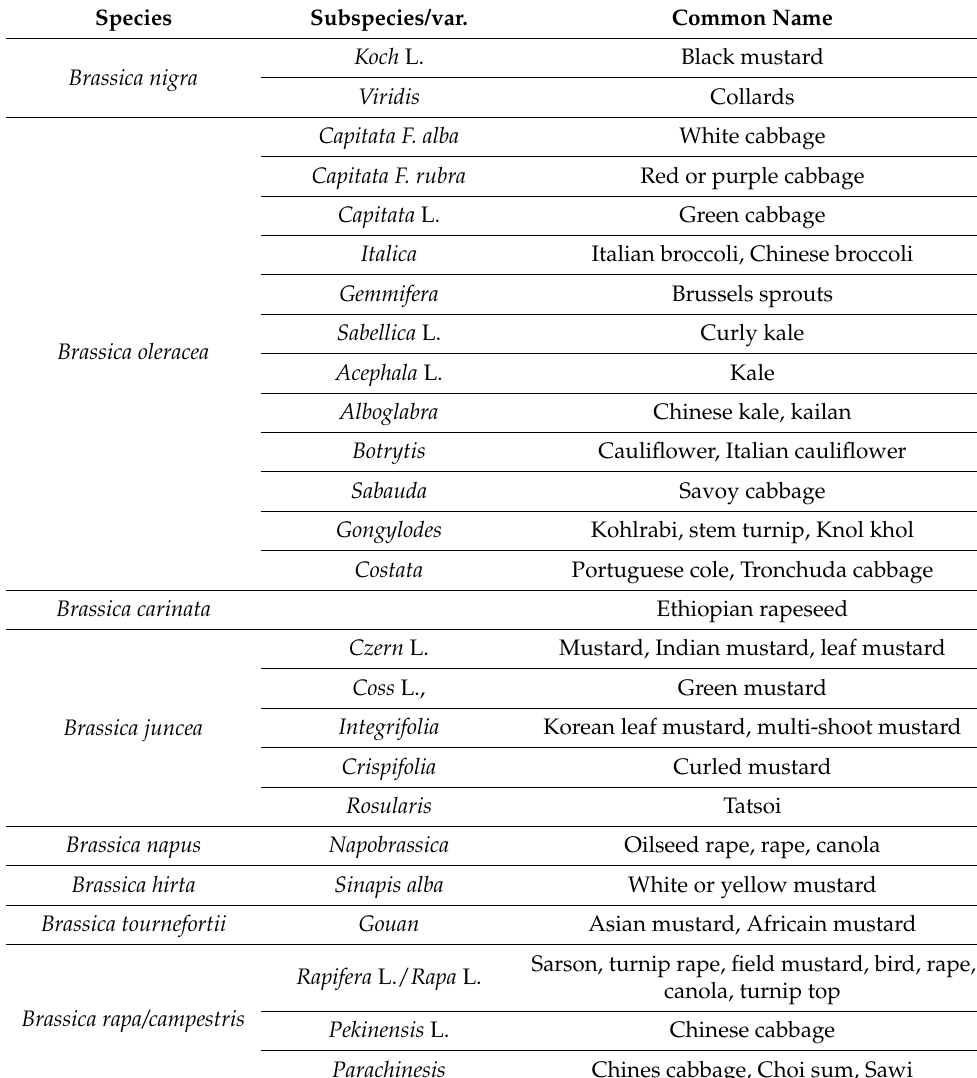
Table 1. Table 1. Diversity of the genus Brassica species